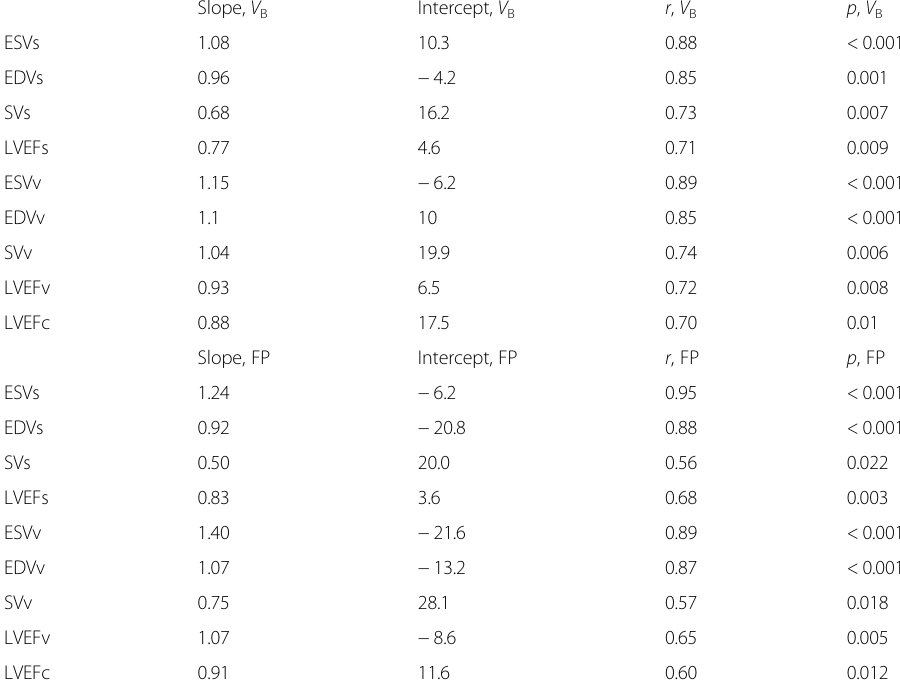
Table 3 Excluding outliers, correlation between PET and MRI for surface- (s), count- (c), and volume-based (v) methods. The count-based method does not provide ESV and EDV values Slope, V B Intercept, V B r , V B p , V